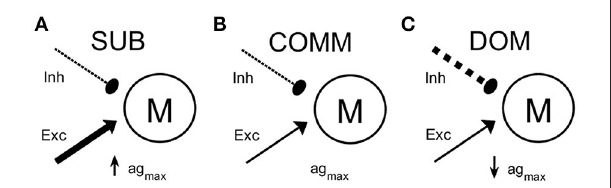
FIGURE 3 | A schematic illustrations of the M-cell escape circuit for all animal groups. The M-cell receives excitatory input (solid line with arrow head) and inhibitory input (dashed line with filled circle). (A) Subordinate-like case (SUB) with higher ag max . (B) Communal-like case (COMM) with moderate ag max . (C) Dominant-like case (DOM) with lower ag max . Thickness represents the strength of the